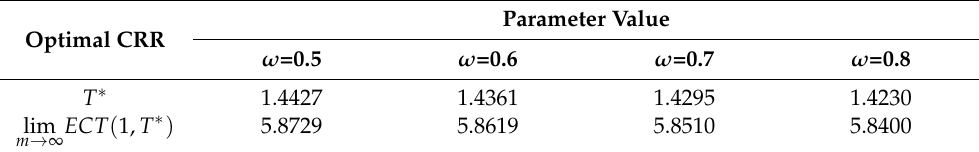
Table 2. The impacts of ω on the optimal CRR.